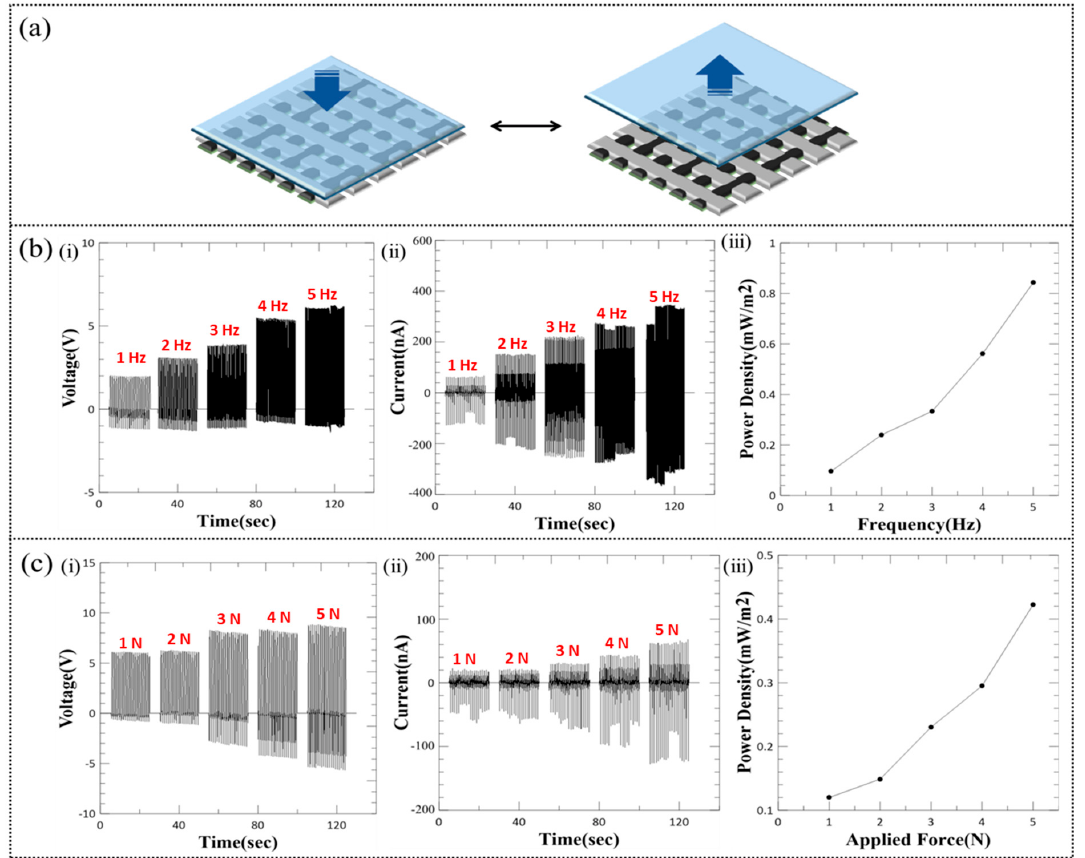
Figure 6. ( a ) Schematic of WTENG working mechanism under non-deformation mode where PDMS is chosen as the freestanding triboelectric layer. The measured (i) voltage (ii) current and (iii) power density when the WTENG is contacted by the freestanding PDMS layer under varying ( b ) frequencies (1–5 Hz) and ( c ) applied forces (1–5 N).